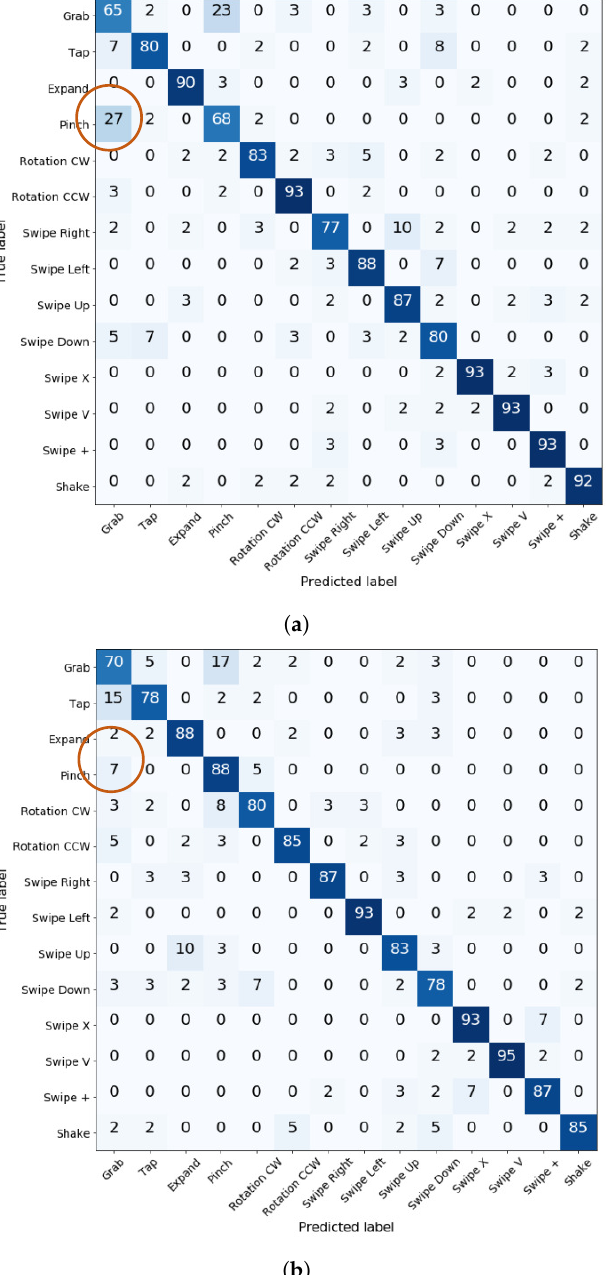
Figure 14. Confusion matrix of prediction results using the MLF LSTM Conv1-2D model with the features motion + skeleton shape (accuracy of 84.52%) ( a ) and joint point-cloud (accuracy of 85.11%) ( b ) on